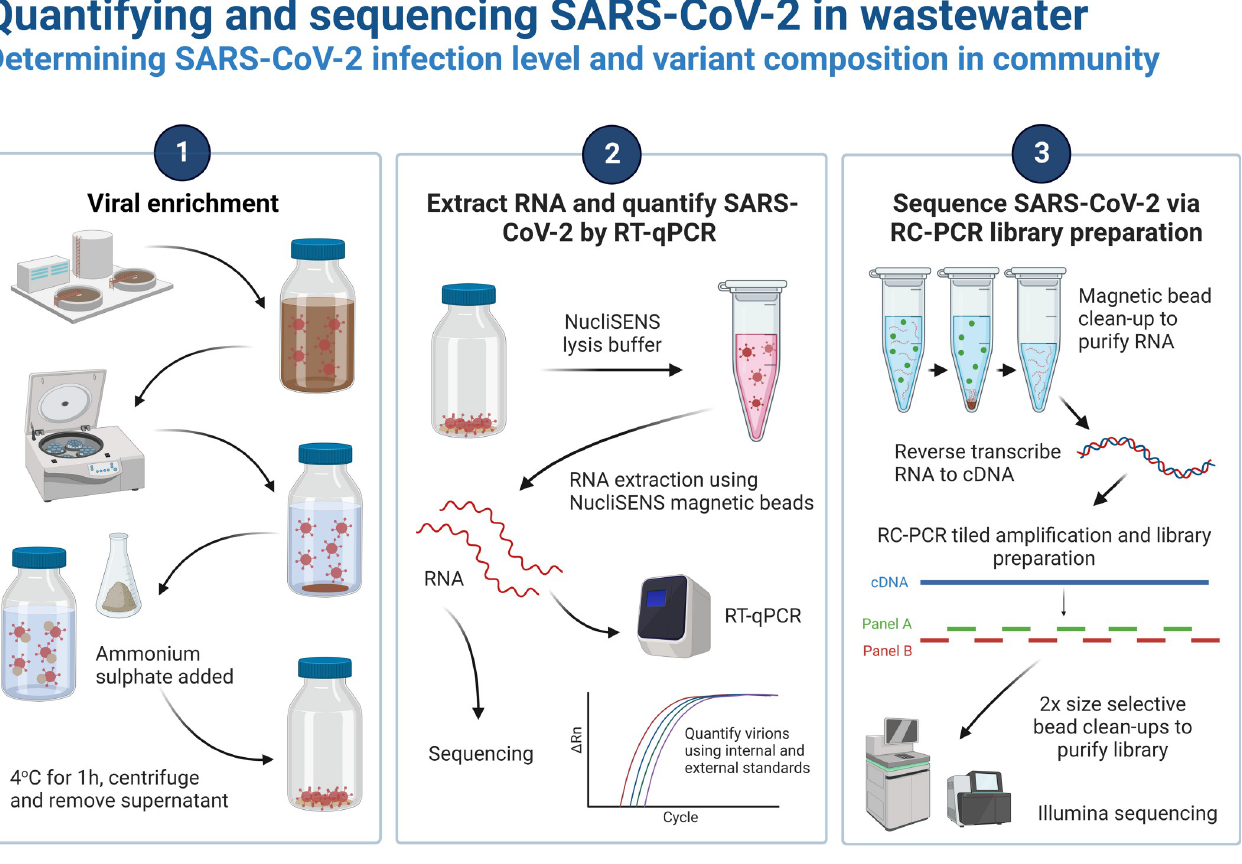
Fig 1. Overview of the protocol used for quantifying and sequencing SARS-CoV-2 in wastewater. Created with Biorender.com.